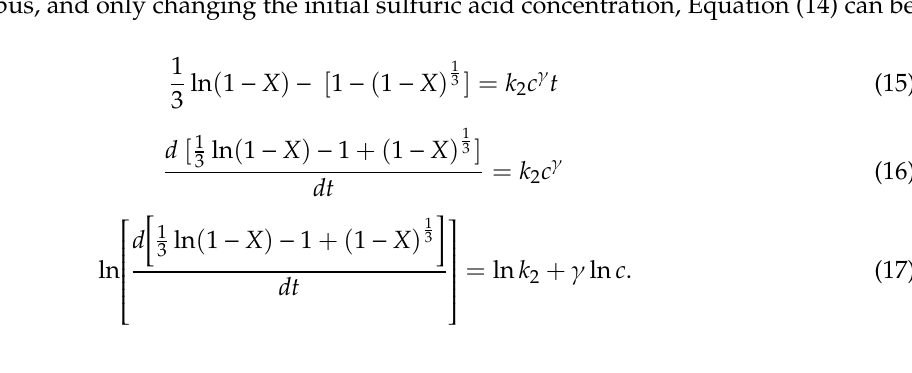
Table 2. R 2 values of shrinking core kinetic models for 2.5 h of leaching at different temperatures. R 2 Values of Shrinking Core Kinetic Models Temperature (K)